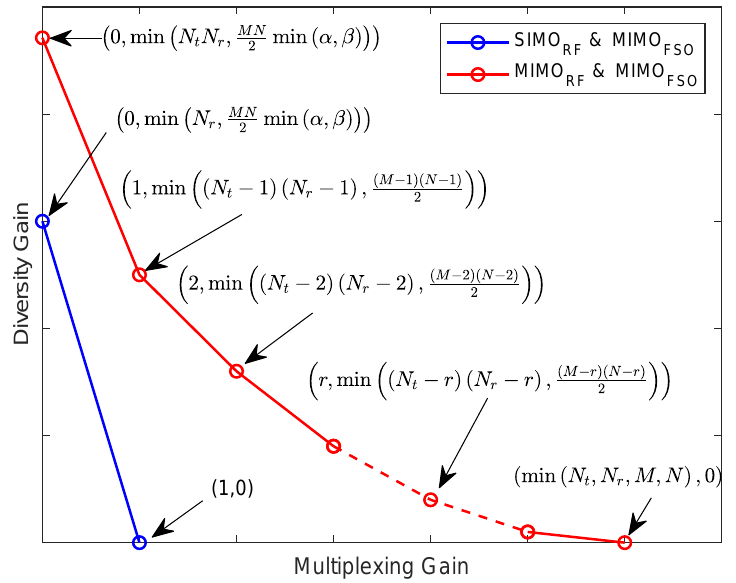
Figure 7. Diversity–multiplexing tradeoff of MIMO mixed RF/FSO system and single input multiple output (SIMO) RF/MIMO FSO system.